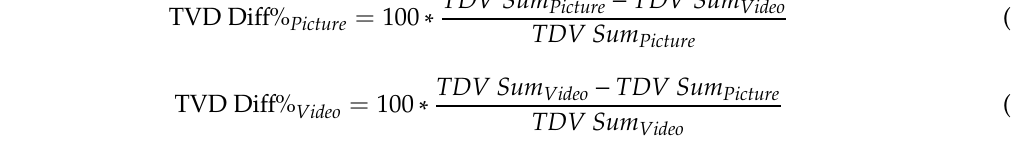
Figure 4. Boundary frames for the creation of dynamic Areas of Interest (AOIs) for the product OnPot.